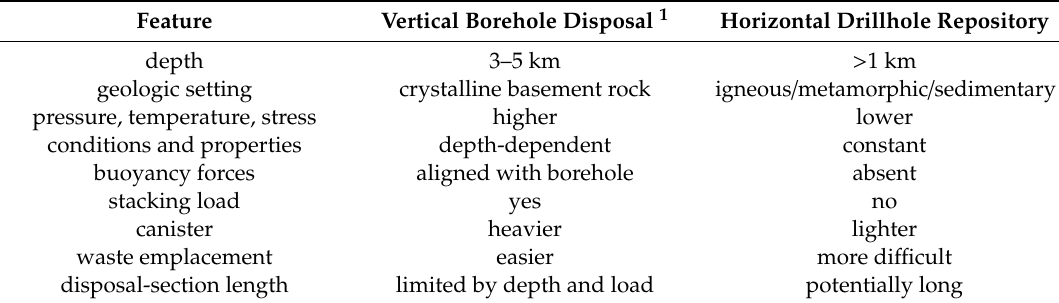
Table 4. Comparison between deep borehole disposal and the proposed deep horizontal drillhole repository